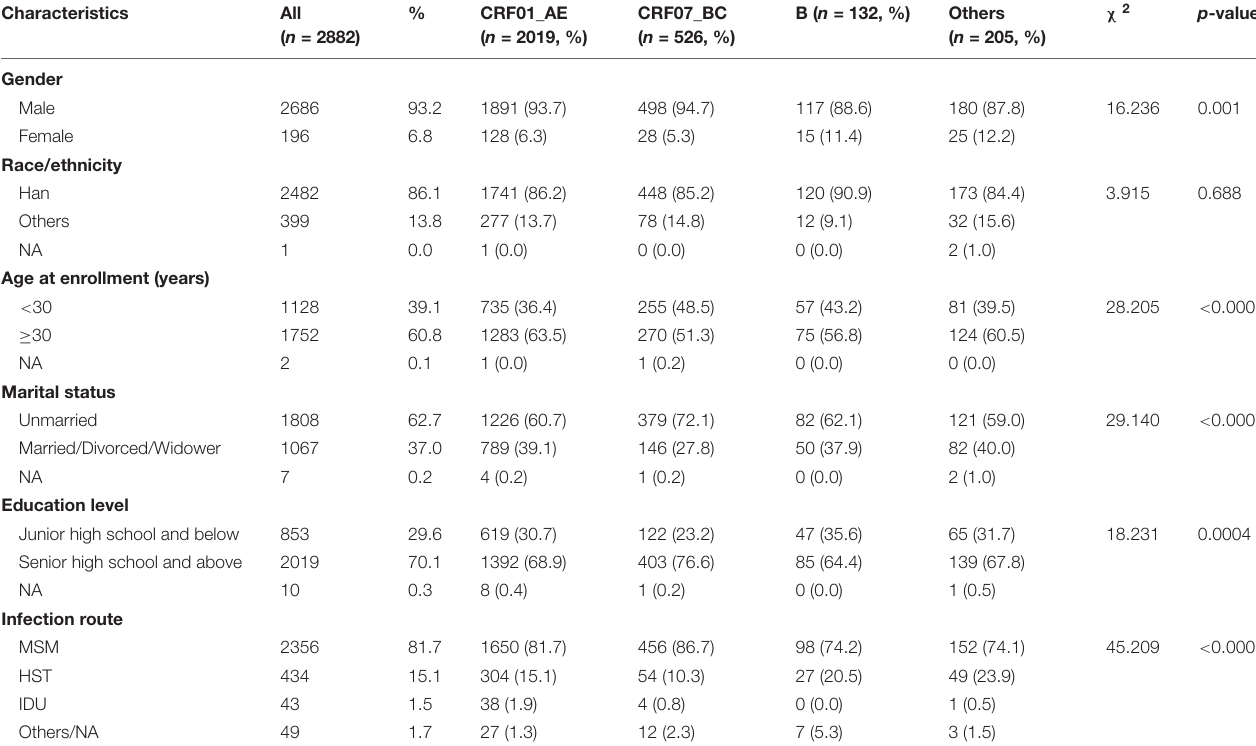
TABLE 1 | The demographic and clinical characteristics of the people living with HIV in four groups. Characteristics